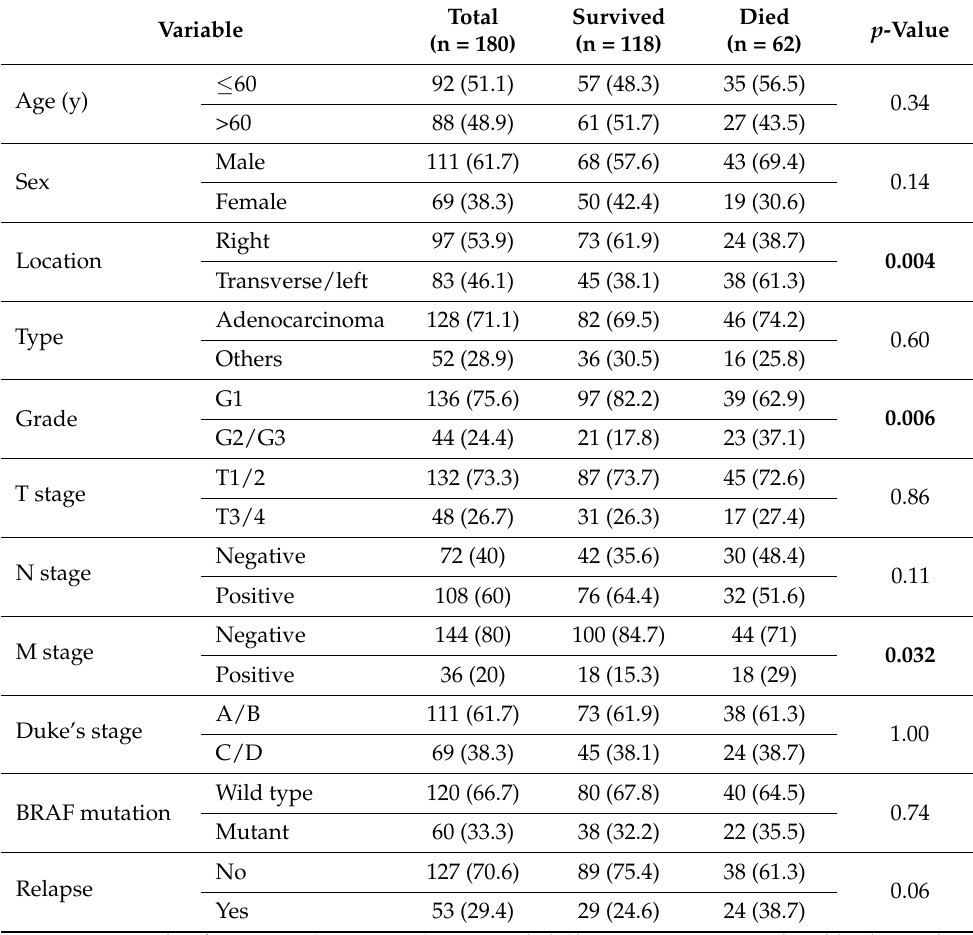
Table 1. Baseline characteristics of the study population according to